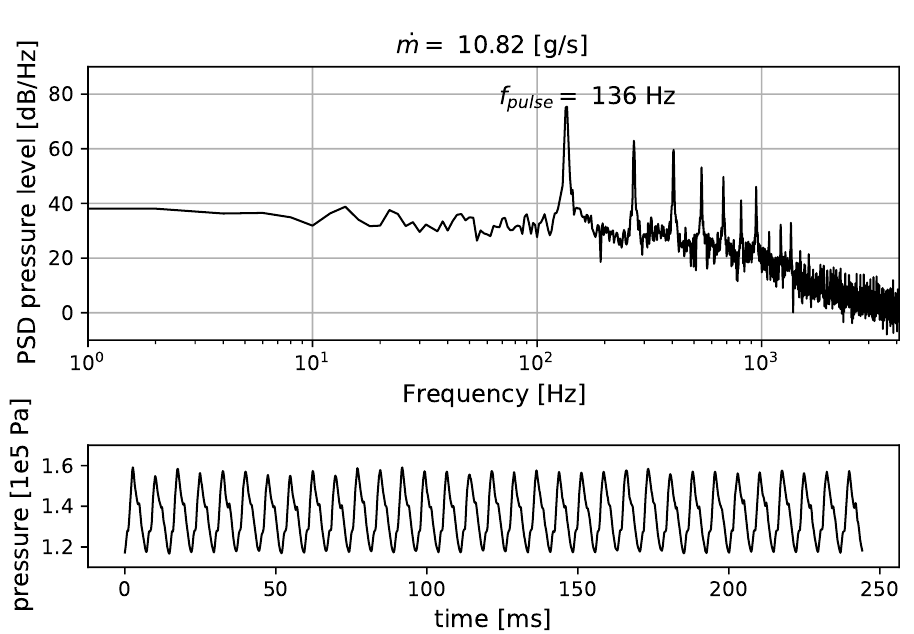
Figure 7. ( top ) Power spectral density of the pressure signal in one settling chamber in the FO-PJA and ( bottom ) a section of the measured